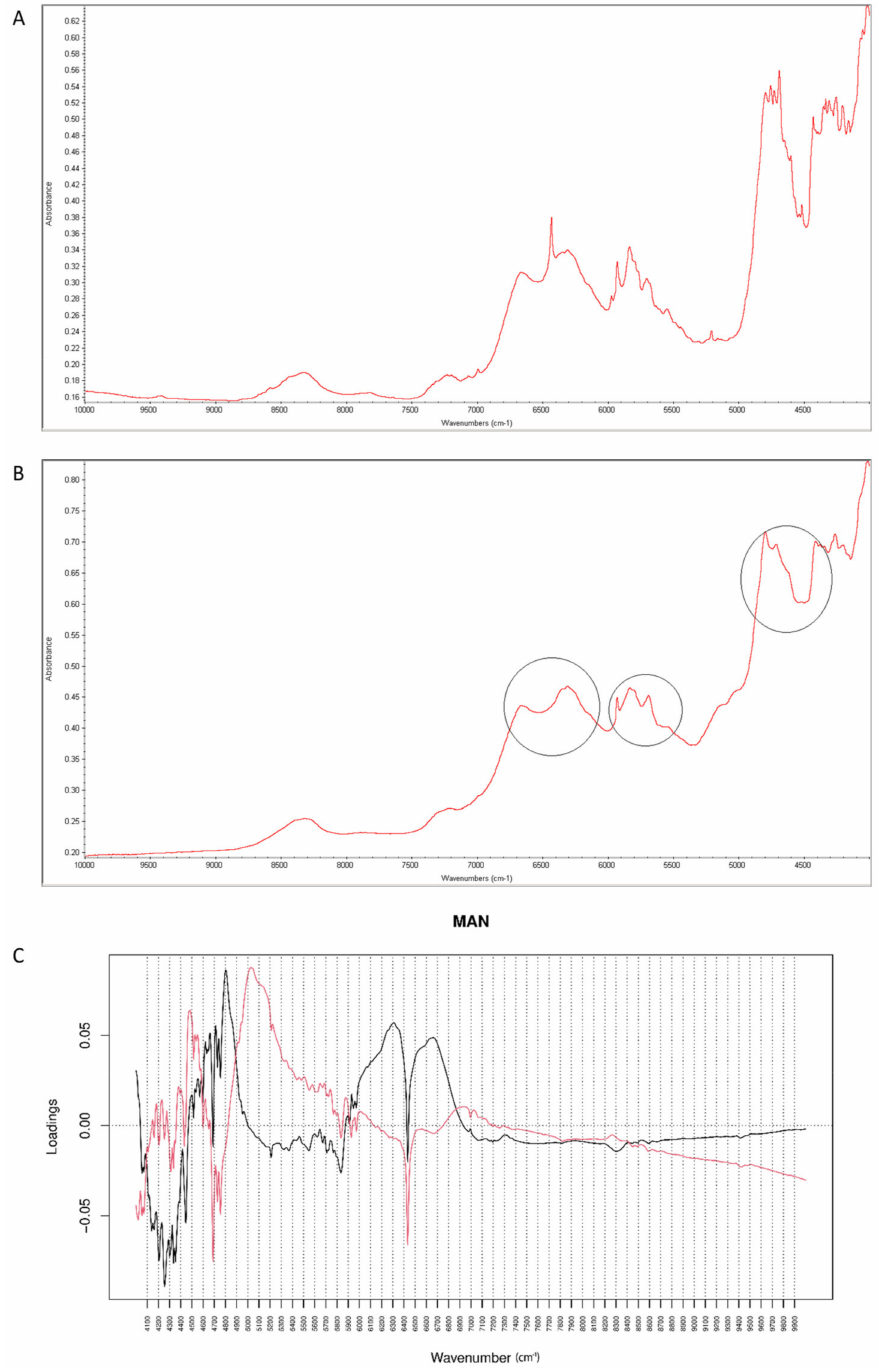
Figure 15. ( A – C ) Vildagliptin and mannitol (MAN): NIR spectra of no stressed mixture ( A ), stressed mixture ( B ) and PCA loadings of the spectra ( C ); PC1 loadings are marked black while PC2 loadings are marked red, most visible differences in the spectrum of the stressed mixture are indicated with